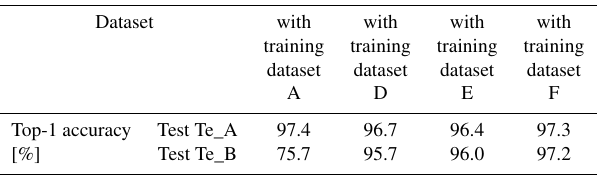
Table 6. Overview of the Top-1 accuracy depending on the data